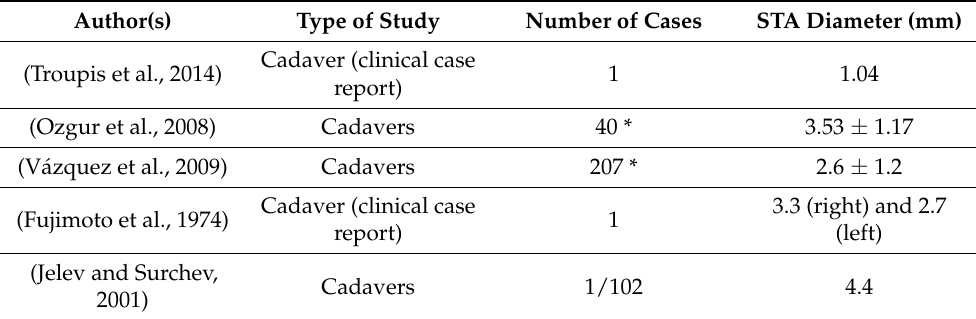
Table 4. Available data concerning the STA